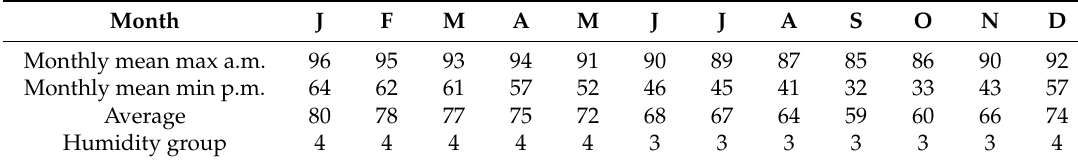
Table 6. Monthly mean relative humidity (%). Table 5. Monthly mean air temperature (°C).